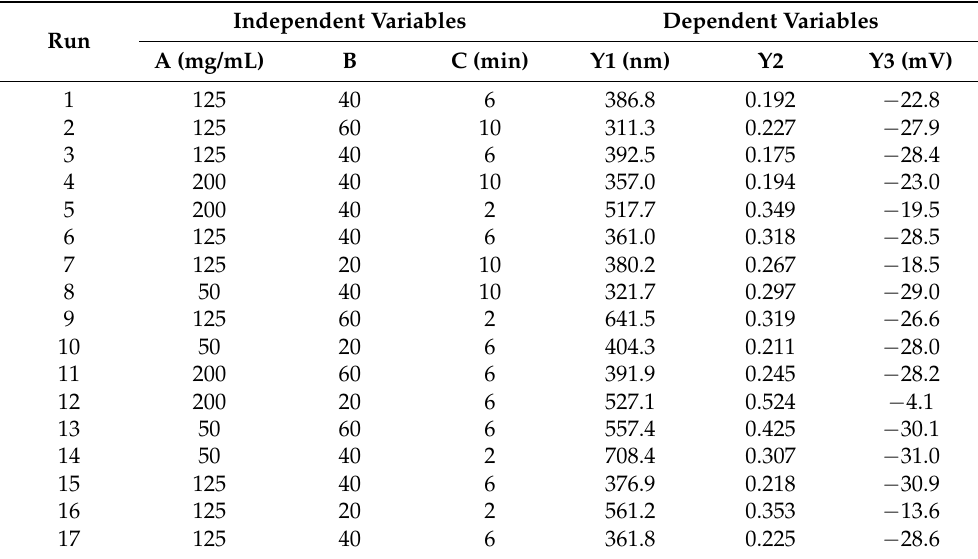
Table 3. Effects of drug concentration in DMSO (A), anti-solvent-to-solvent ratio (B), and sonication time (C) on particle size (Y1), polydispersity index and (Y2), and zeta potential (Y3) of Bre-NS during